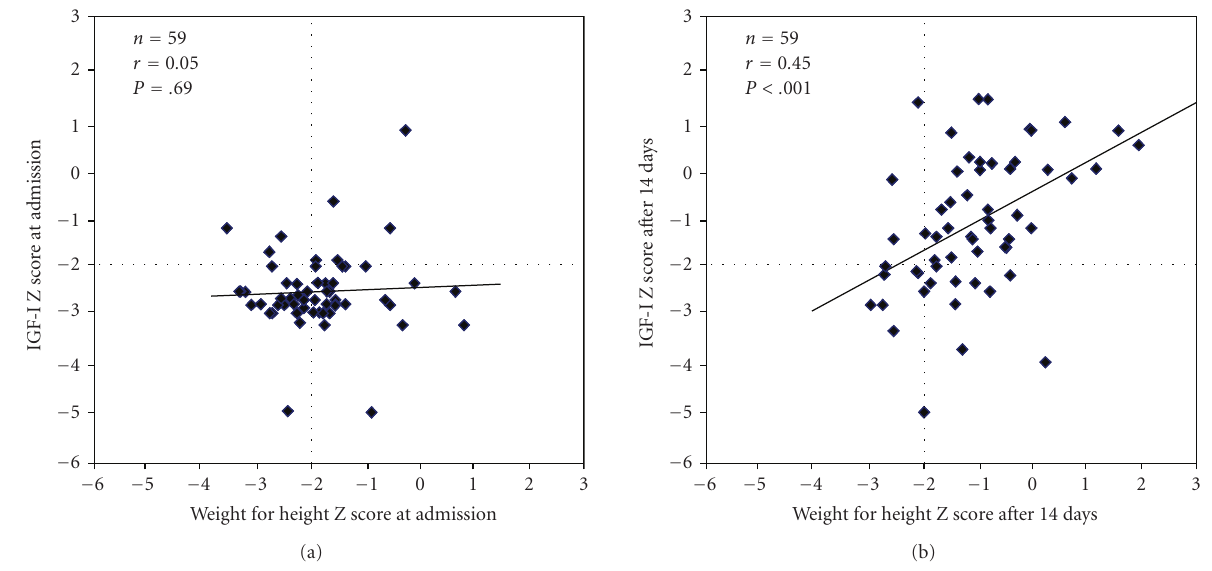
Figure 2: Relationship between age- and sex-adjusted IGF-I Z-score and weight for height Z-score with Burkina Faso data as references, at admission and after 14 days of nutritional rehabilitation in 59-malnourished children from Burkina